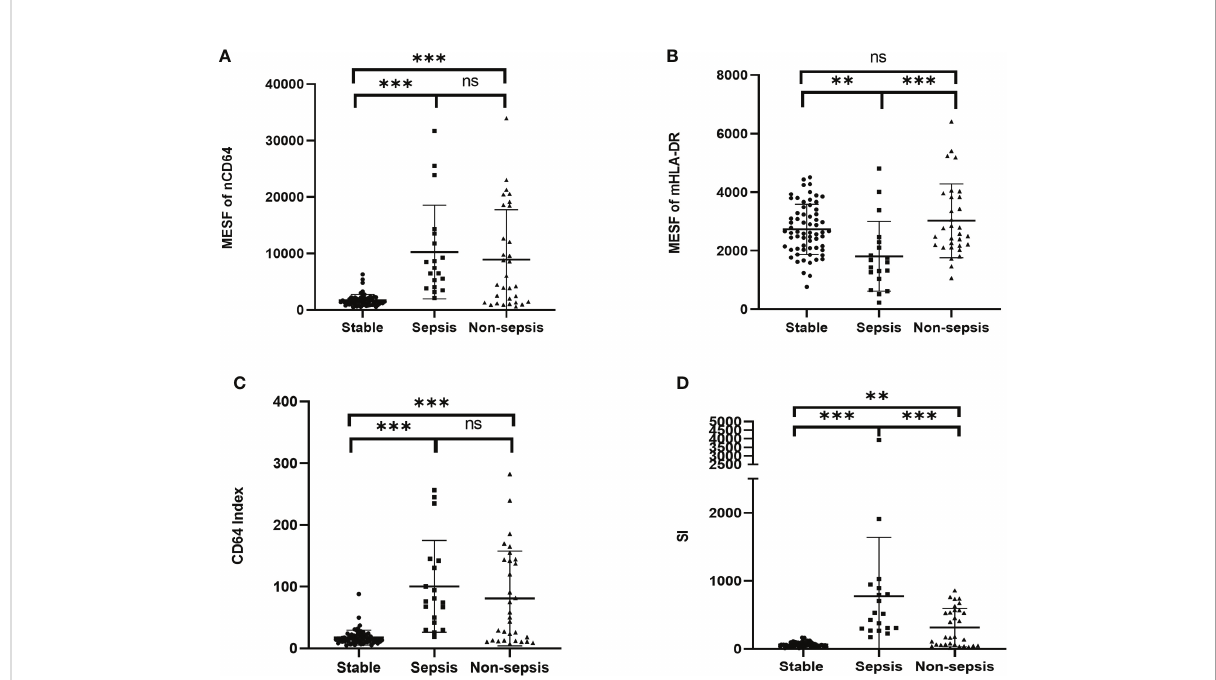
FIGURE 7 Comparison of the MESF of nCD64 (A) , MESF of mHLA-DR (B) , CD64 index (C) and SI (D) between the stable, the sepsis and the non-sepsis groups. Tested by the least signi fi cant difference test for back testing of multivariate ANOVA. *** means P < 0.001 and ** means P < 0.01. nCD64, neutrophil CD64; mHLA-DR, monocyte HLA-DR; HC, Healthy controls; KTRs, kidney transplant recipients; MESF, molecules of equivalent soluble fl uorochrome; SI, Sepsis index. ns, no signi fi